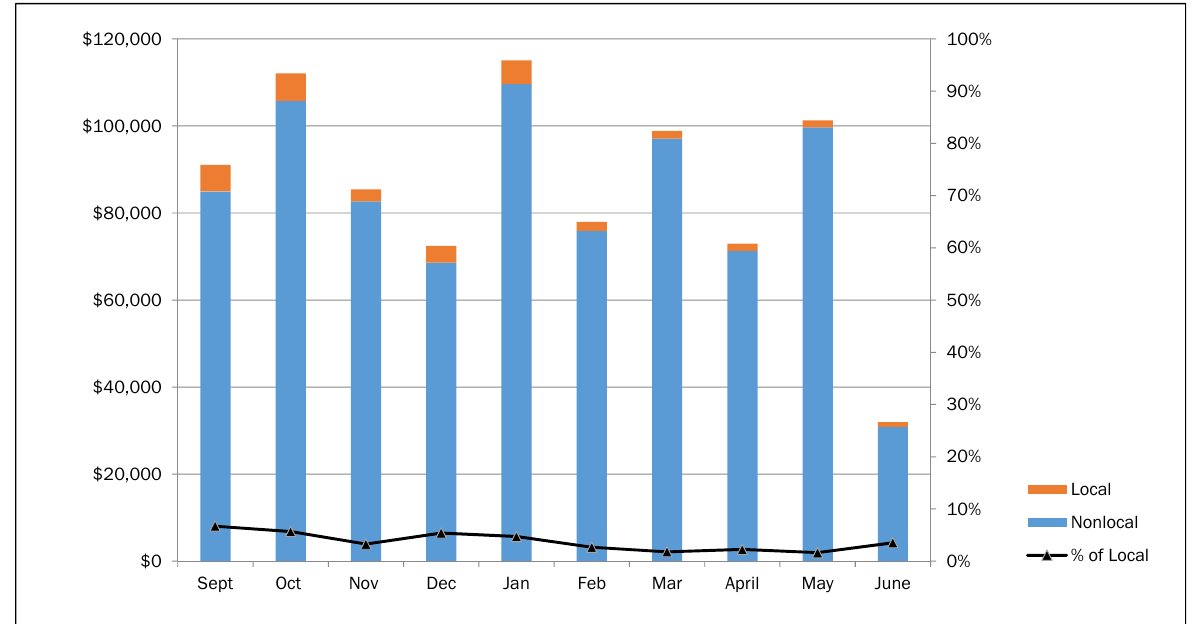
Figure 1. Total USDA Fresh Fruit and Vegetable Program (FFVP) Purchases by Vermont Public Schools, Local Versus Nonlocal ( N =115) and Percentage of Purchases That Are